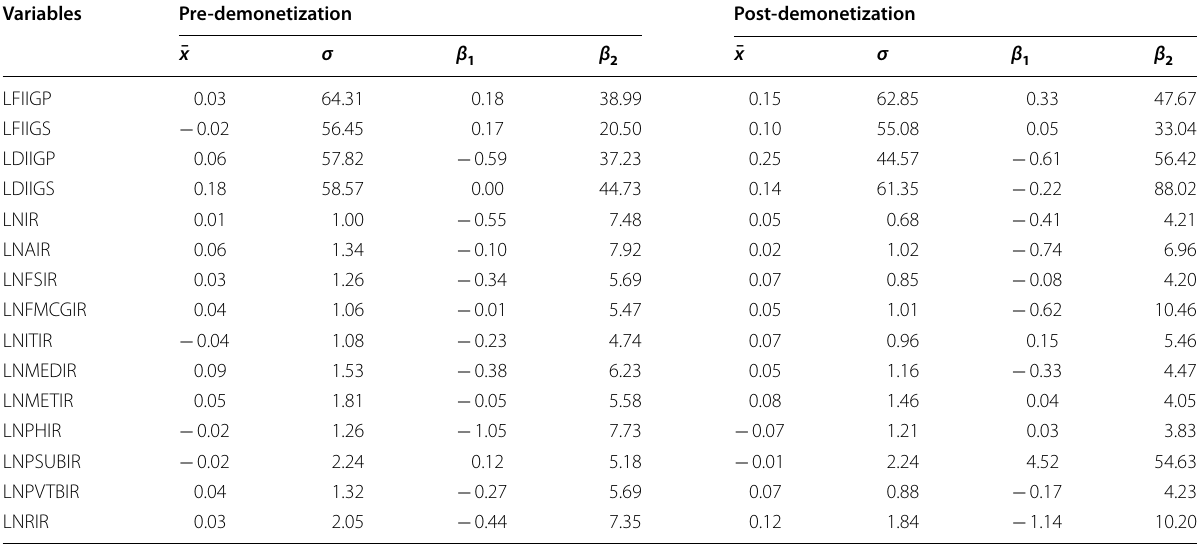
¯ x , σ , β 1 and β 2 represent mean, SD, skewness and kurtosis, respectively LFIIGP FII Gross Purchase, LFIIGS FII Gross Sales, LDIIGP DII Gross Purchase, LDIIGS DII Gross Sales, LNIR Nifty 50 Index Returns, LNAIR Nifty Auto Index Returns, LNFSIR Nifty Financial Services Index Returns, LNFMCGIR Nifty FMCG Index Returns, LNITIR Nifty IT Index Returns, LNMEDIR Nifty Media Index Returns, LNMETIR Nifty